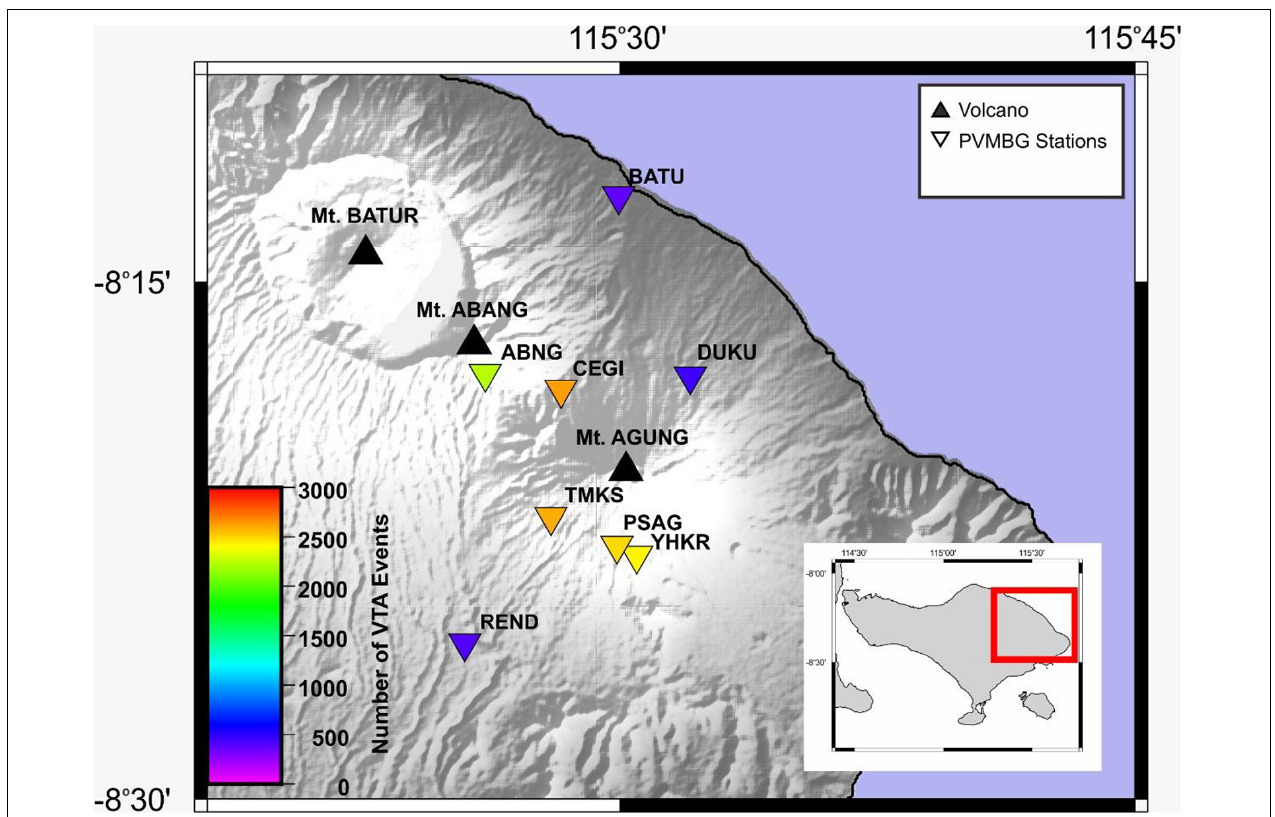
FIGURE 1 | Map of the eight local permanent stations deployed by CVGHM to monitor activity at Mt. Agung (inverted triangles). The number of detected VT events at each station during the study period is represented in a color scale. Black triangles show Agung, Abang, and Batur volcanoes. Inserted map shows Bali